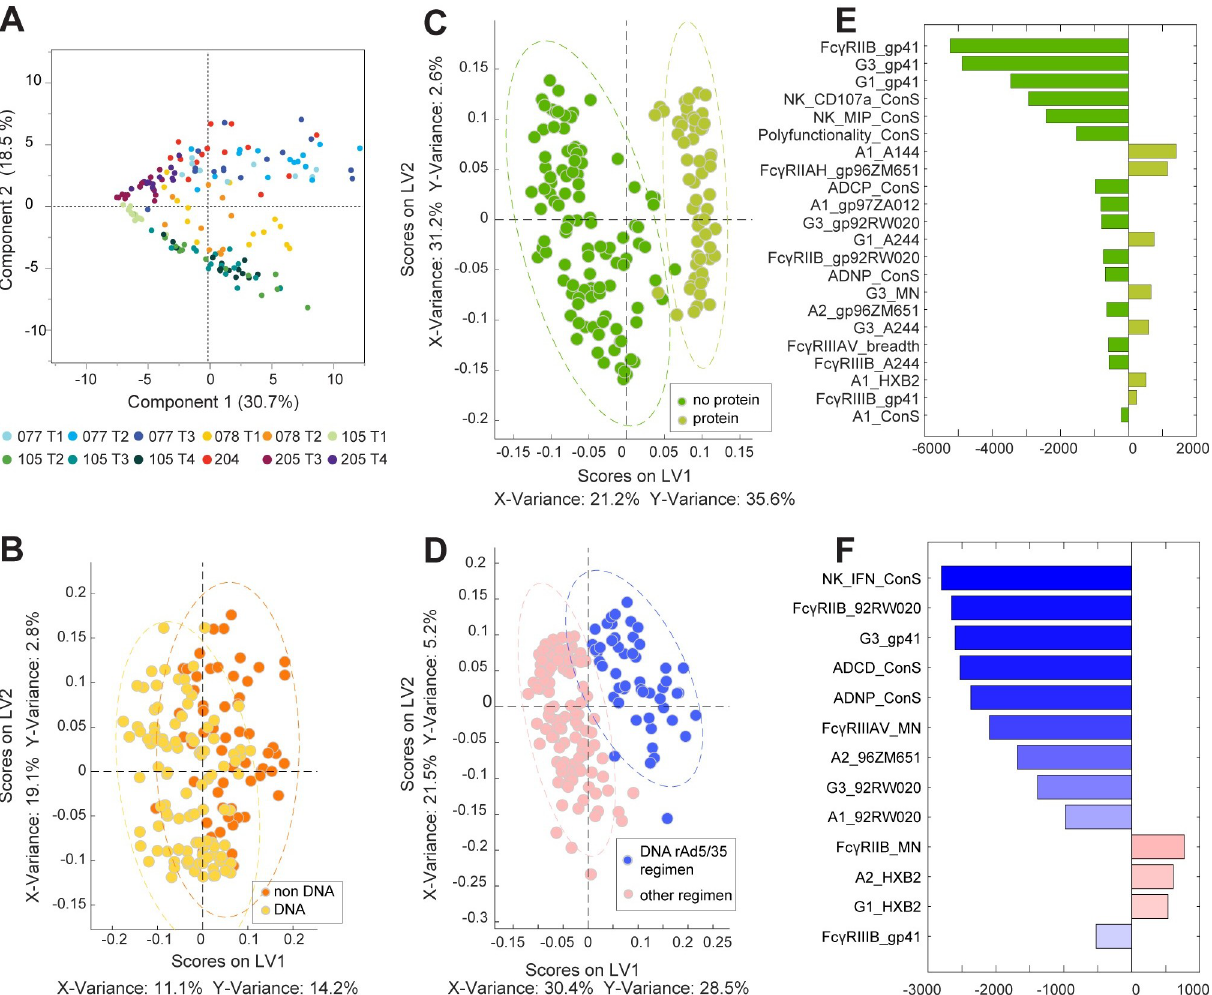
Fig 4. DNA and rAd5 including regimens induce distinct antibody profiles. Multivariate analysis of antibody profiles using 69 features for each plasma sample was performed. A: An unsupervised principal component analysis (PCA) was first used and demonstrates the separation of the different vaccine trials based on their antibody profiles. Each dot represents one vaccinated individual at peak immunogenicity and the colors indicate the trial arm as depicted in the legend. Next using a supervised PLSDA, differences in antibody profiles was examined in: B: DNA containing regimens (HVTN 077 T2, T3; 105 T1, T2, T3; 204; 205 T3) versus trials which do not incorporate DNA in their vaccine regimen (HVTN 077 T1; 078; 105 T3; 205 T4)- with a model accuracy of 77.3%; C: protein containing regimens (HVTN 105 all arms) compared to non-protein containing immunizations (HVTN 077, 078, 204, 205, all arms), with a model accuracy of 75.8%; and D: DNA/rAd containing regimens (HVTN 077 T2, T3; 204) versus all other regimens (HVTN 078, 105, 205) -with a model accuracy of 90.7%. E and F show the antibody features that were differed most significantly across the vaccine groups, ranked based on their Variable in Projection Score (VIP). Features are color coded based on the vaccine group in which they were enriched. E: variables pointing to the left (dark green) are enriched in vaccines without a protein component whereas features pointing to the right are increased in protein vaccine trials (light green). F: Features that point to the left were enriched in DNA + rAd5/rAd35 trials (blue), while those ordered on the right side are enhanced in other vaccine regimen trials